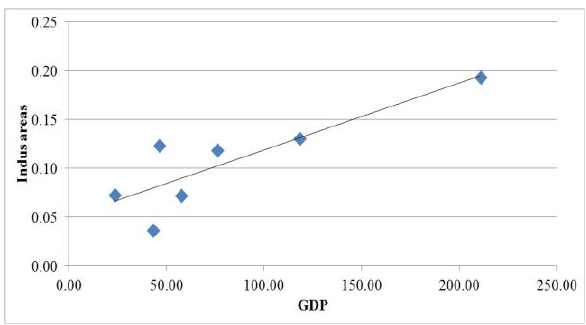
Figure 18. Relationship between GDP and Industrial areas for 2010 ( R 2 = 0.66)